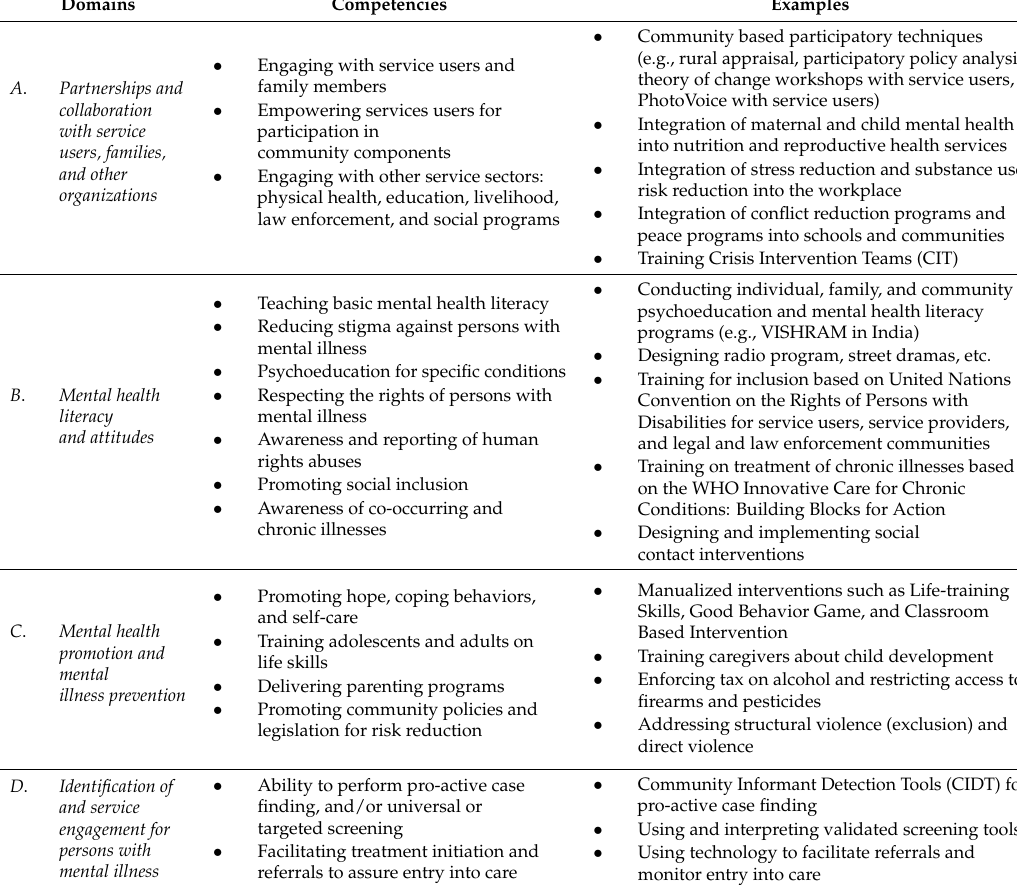
Table 4. Competencies needed for community mental health